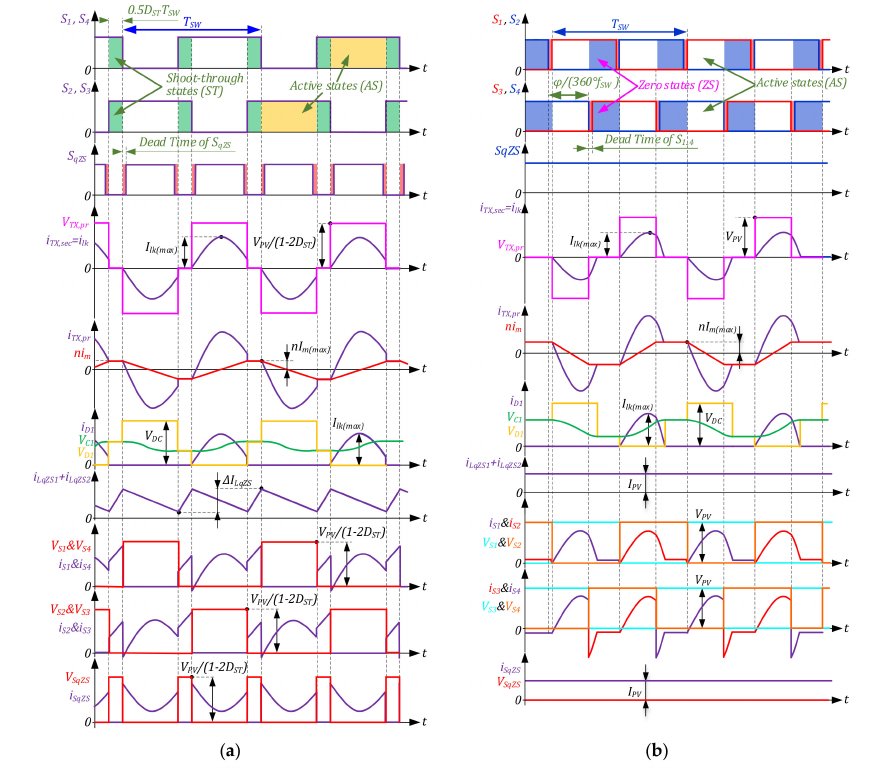
Figure 3. Operating waveforms of the qZS IBBC in the boost ( a ) and buck ( b ) operation